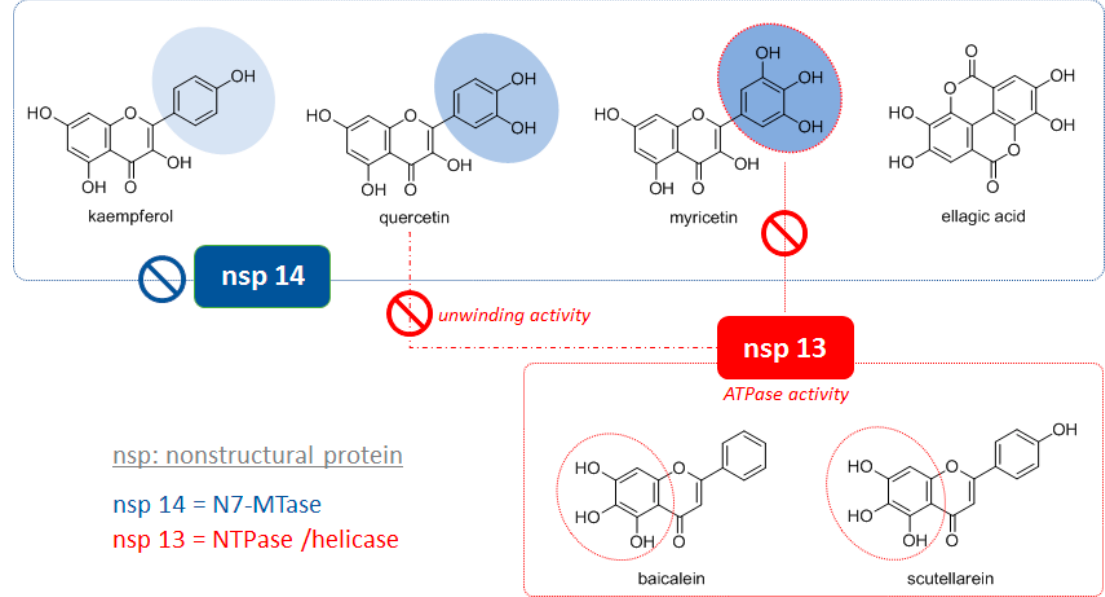
Figure 8. Chemical structures of polyphenols active on CoV nonstructural proteins involved in replication. In the blue box compounds able to inhibit nsp 14 (N7-MTase) are reported. In the three flavonols the chemical feature likely responsible for the activity (ring B) is highlighted. In the red box compounds acting vs. nsp 13 are reported. They share with myricetin the same mode of action, which is di ff erent from quercetin (see text for